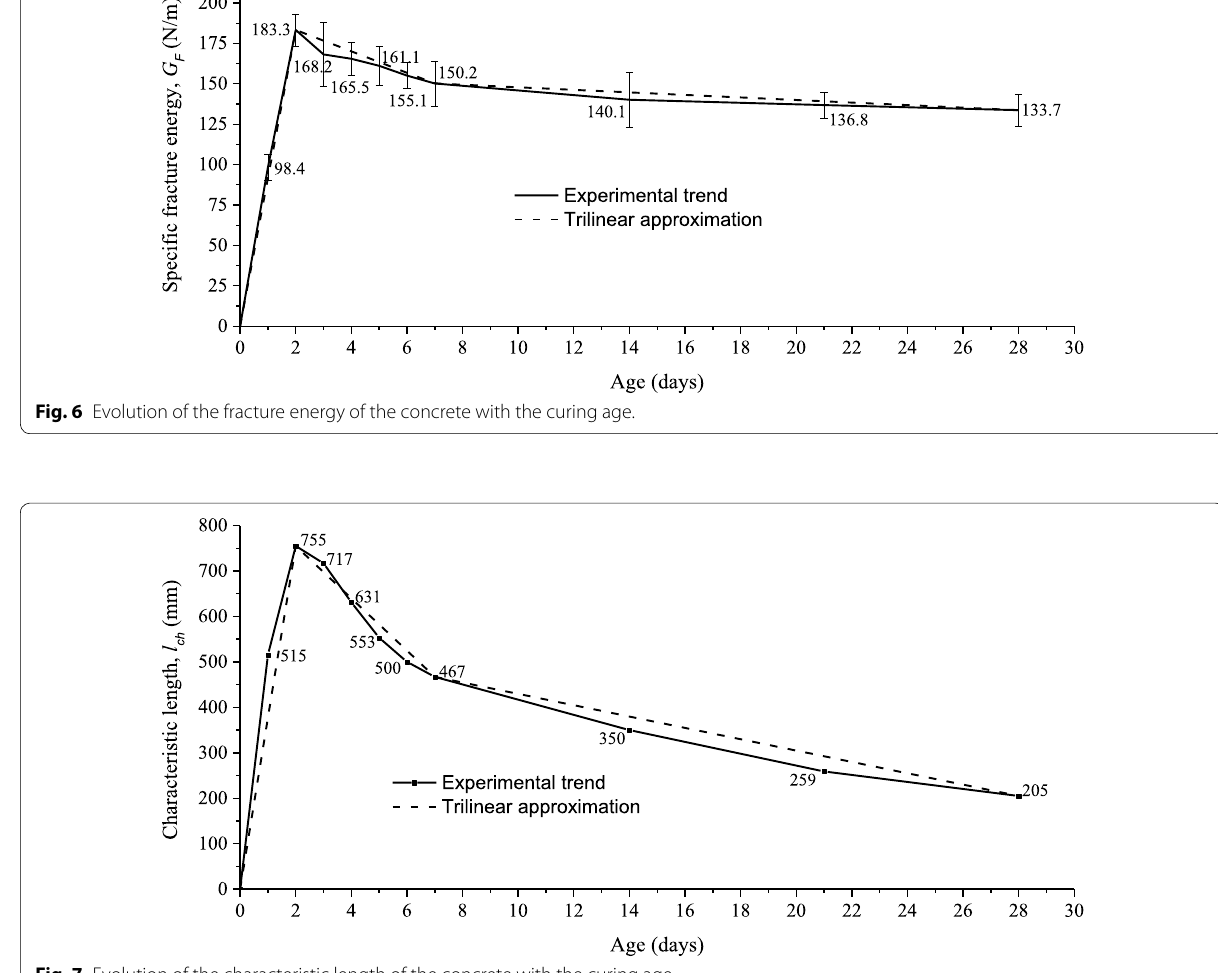
Fig. 7 Evolution of the characteristic length of the concrete with the curing